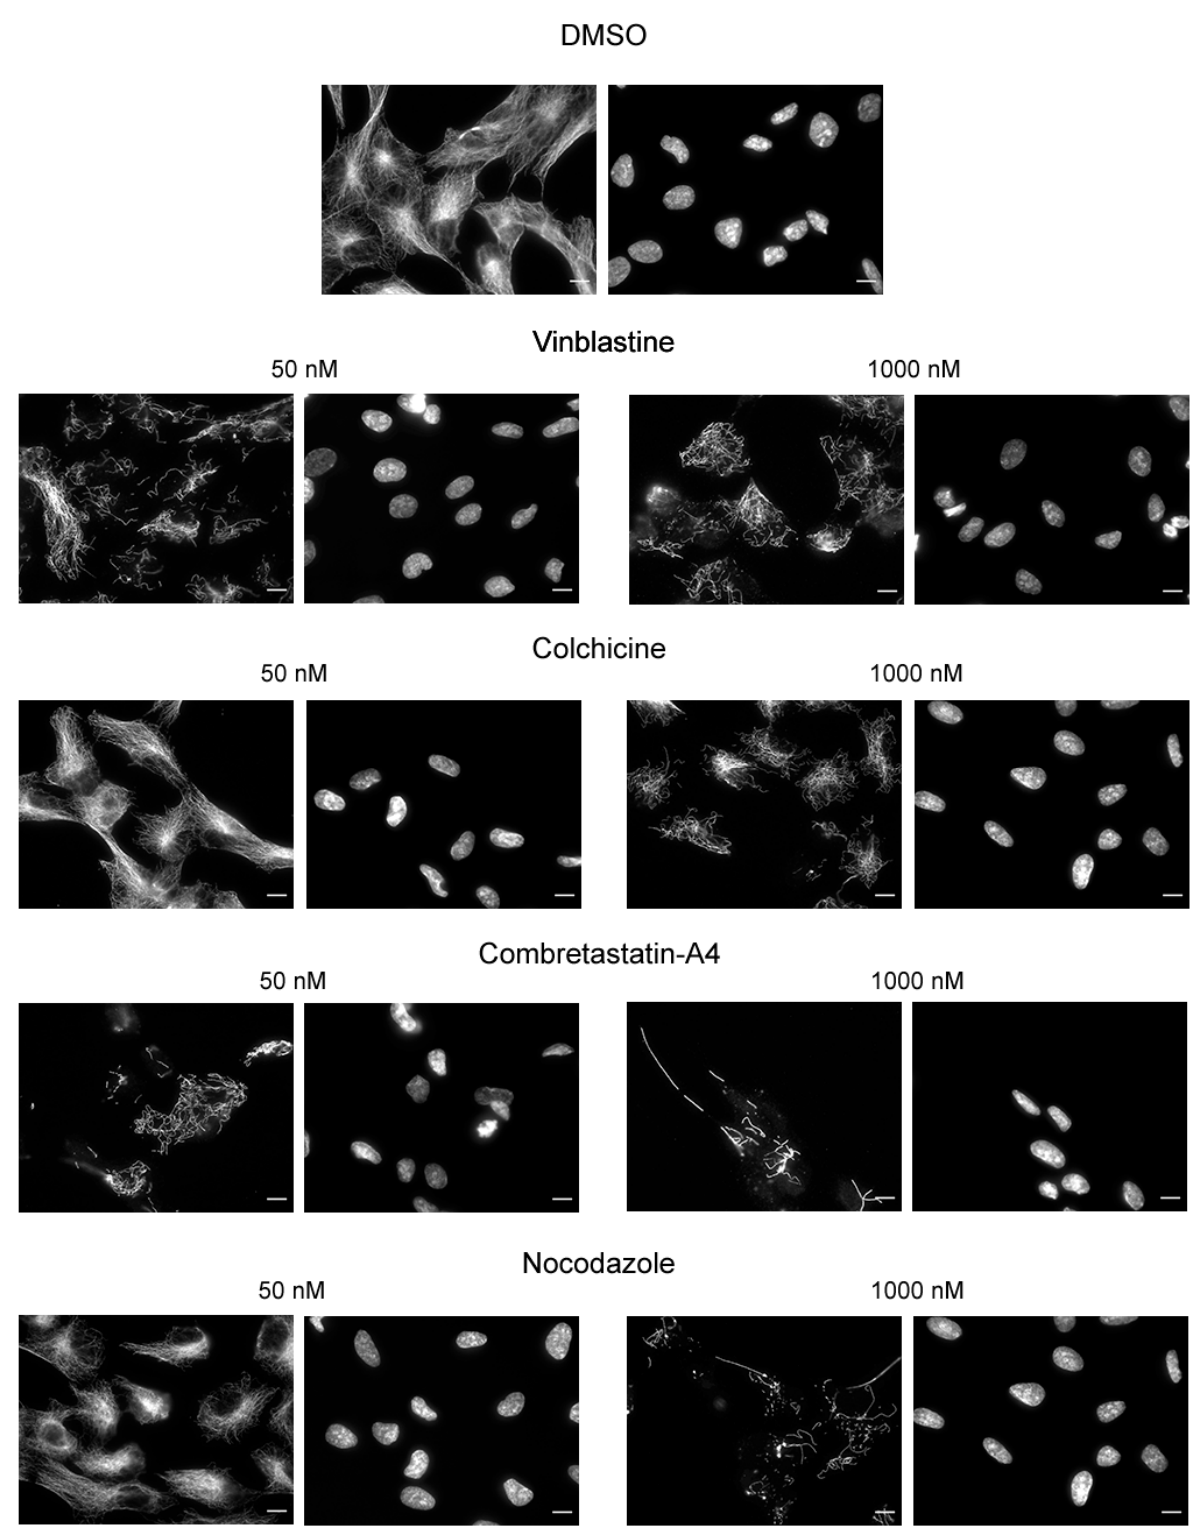
Figure 5. Immunofluorescence analysis of the effect of the reference compounds on RPE1 cell microtubules. RPE1 cells were incubated for 30 min with the compounds at the indicated concentrations or with DMSO (control). Cells were then permeabilized and processed for immunofluorescence using an anti- α -tubulin antibody. Nuclei are stained with Hoechst 33258. Scale bars, 10 µm.